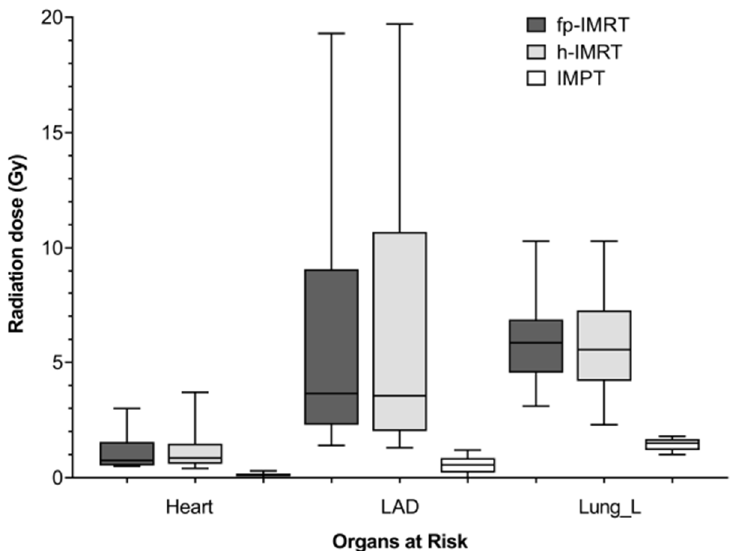
Figure 1. Boxplots showing mean doses received by the heart, LAD, and left lung grouped by technique. Boxes show interquartile range, line within box indicates median and whiskers show minimum and maximum values. All n = 16. Abbreviations: fp-IMRT—forward planned intensity-modulated radiation therapy; h-IMRT—hybrid intensity-modulated radiation therapy; IMPT—intensity modulated proton therapy; LAD—left anterior descending artery. Table 2. Differences in target volume parameters between fp-IMRT, h-IMRT, and IMPT plans, n = 16 Plan parameter